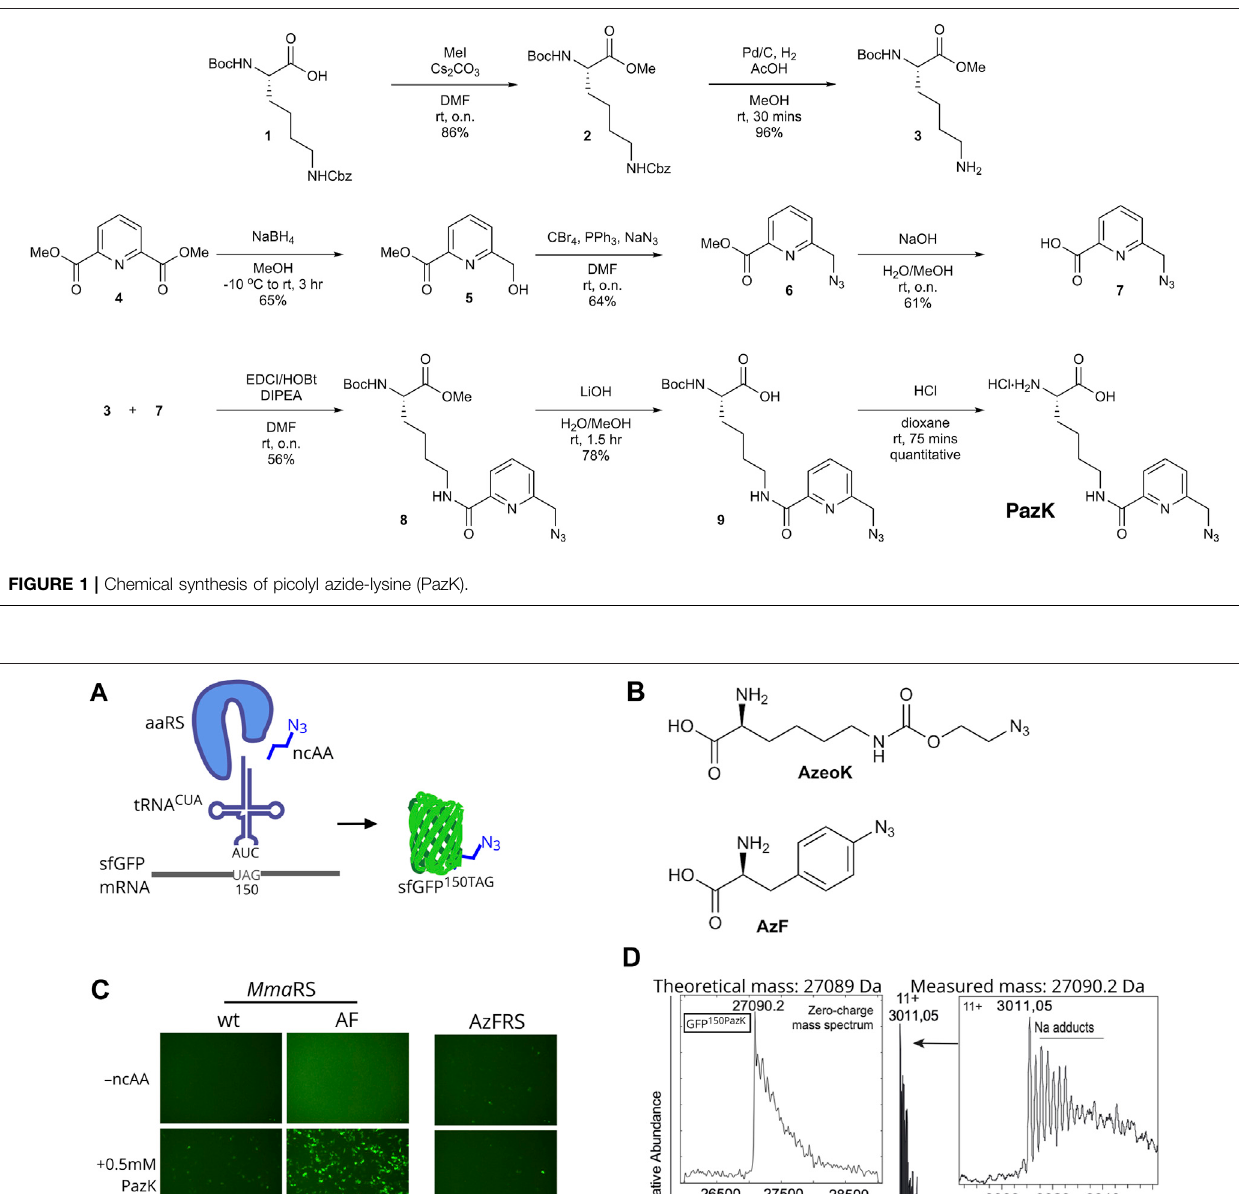
Frontiers in Chemistry |